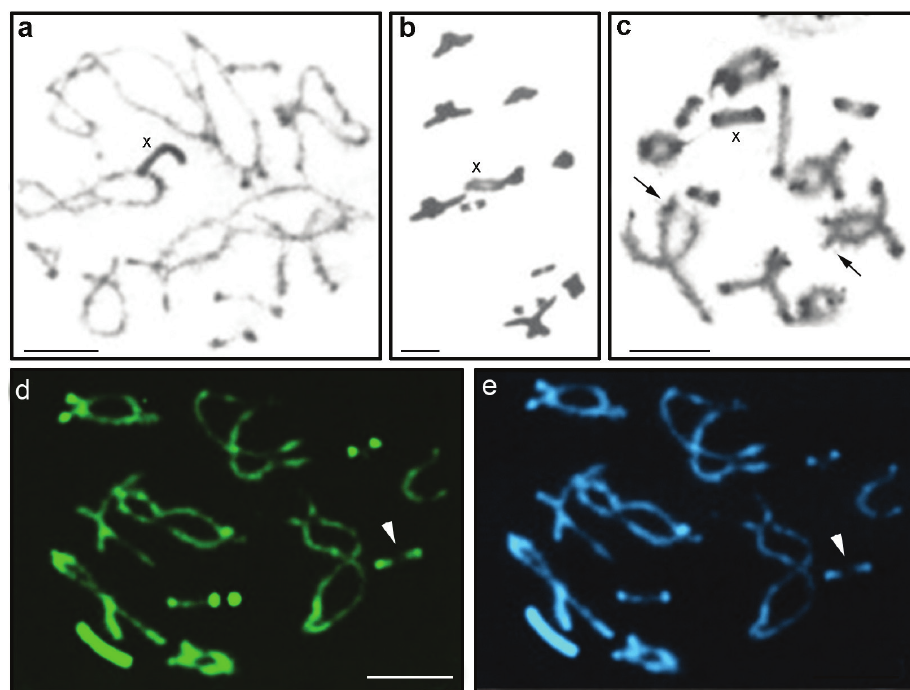
Figure 3. Meiotic stages of T. collaris . a pachytene b diakinesis c C-banding d CMA staining. Arrows indicate C + subterminal blocks in larger pairs and in M gous form. Bar = 10